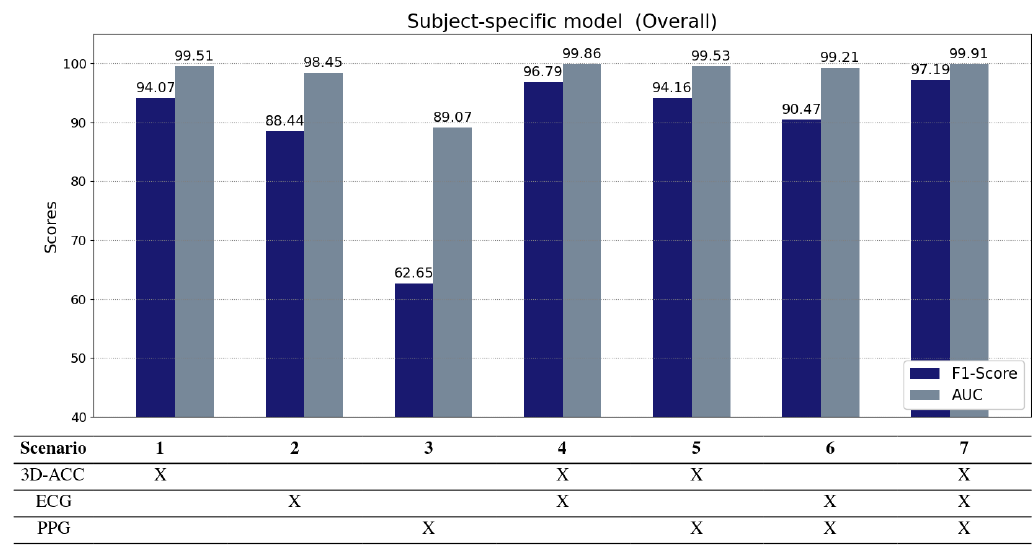
Figure 5. Subject-specific model